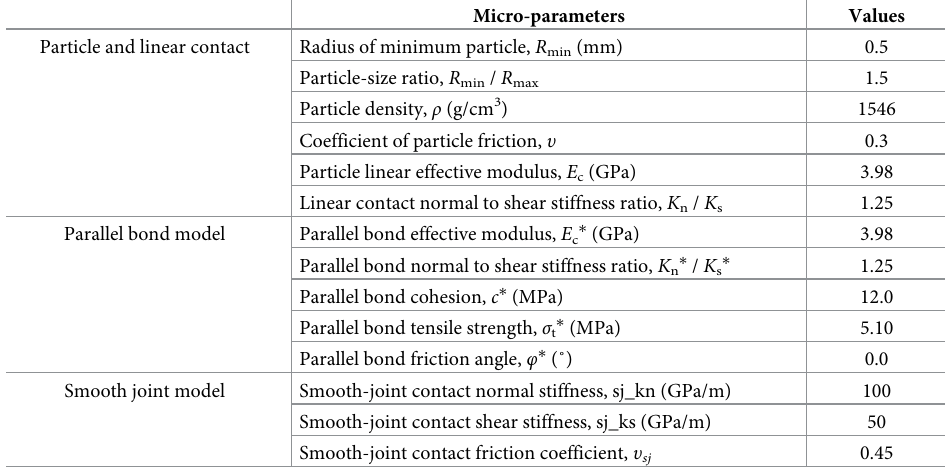
Table 1. Micromechanical parameters of PFC numerical